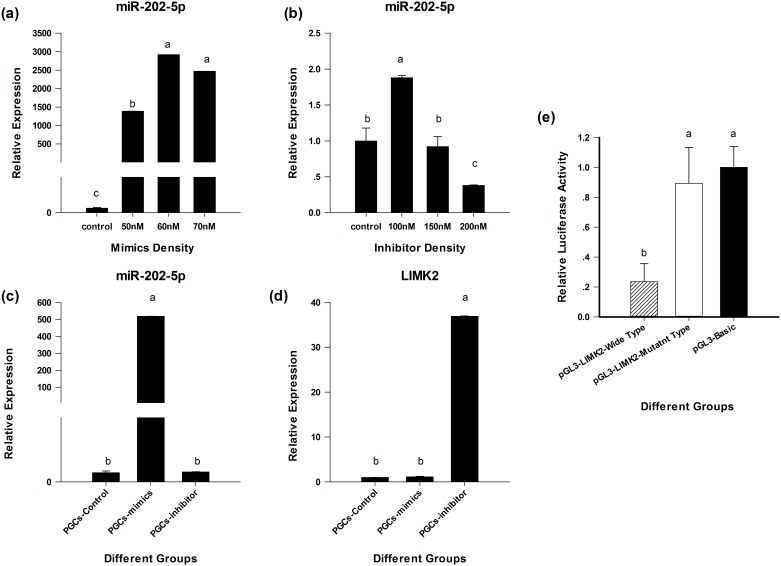
miR-202-5p bind to LIMK2 genes in chicken.Lowercase letters indicated p <= 0.01.